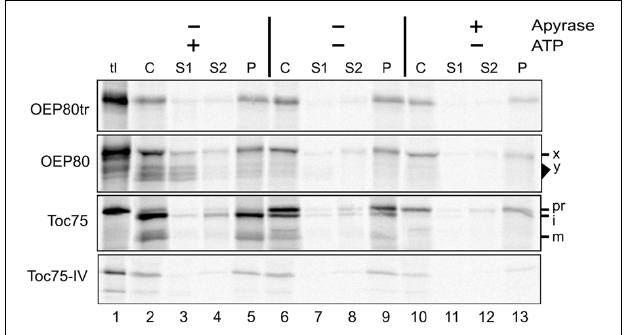
FIGURE 5 | Energy requirement for OEP80tr import in vitro . Translation products including the radiolabeled proteins indicated at left (tl) were incubated without (–) or with ( + ) apyrase at room temperature for 15min in the light. The resultant samples were incubated with isolated chloroplasts without (–) or with ( + ) 3mM MgATP for 30min at room temperature in the dark. Chloroplasts were re-isolated, fractionated and examined as described in Figure 4A .